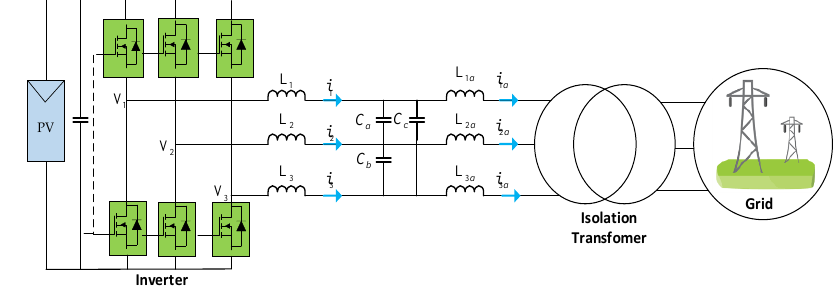
Figure 2. Main components of grid connected PV systems.